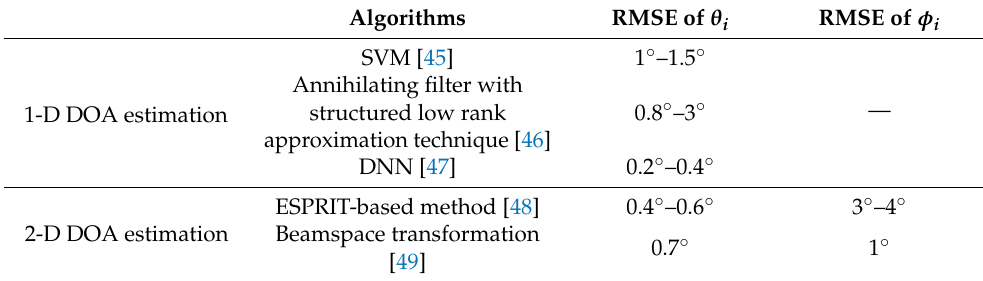
Table 6. The accuracy of other state-of-the-art signal processing-based DOA estimation algorithms. Algorithms RMSE of θ i RMSE of φ i SVM [45] 1 ◦ –1.5 ◦ —Annihilating filter with structured low rank 0.8 ◦ –3 ◦ 1-D DOA estimation approximation technique [46] DNN [47] 0.2 ◦ –0.4 ◦ ESPRIT-based method [48] Beamspace